Question: In a single sentence, describe what this figure presents.
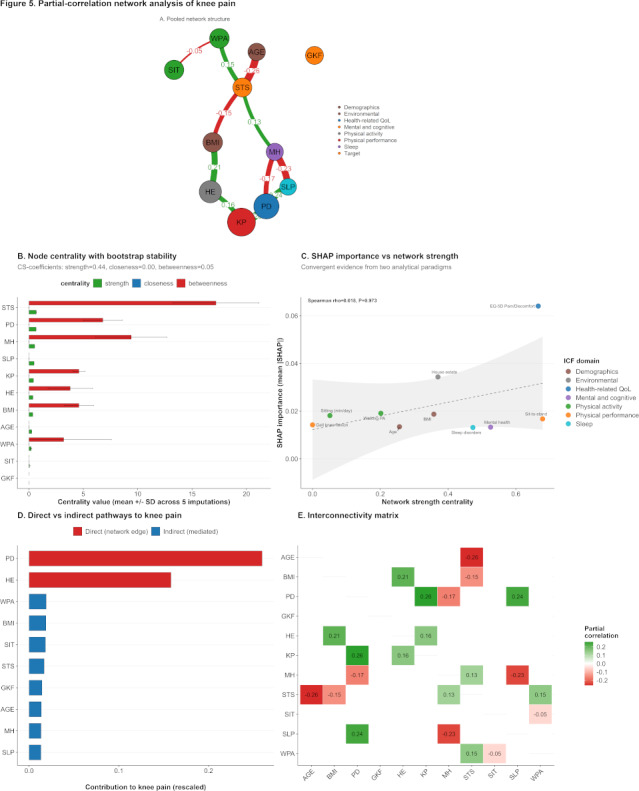
Answer: Partial-correlation network, centrality, paradigm concordance, and pathway decomposition. (A) Pooled network structure, (B) node centrality with bootstrap stability, (C) linkage between SHAP importance and network strength centrality, (D) direct versus indirect pathways to knee pain, and (E) interconnectivity matrix. CS: correlation-stability; EBICglasso: graphical LASSO with extended Bayesian information criterion regularization; GKF: gait knee flexion; HE: house estate; ICF : International Classification of Functioning, Disability and Health ; KP: knee pain; LASSO: Least Absolute Shrinkage and Selection Operator; MH: mental health; ML: machine learning; PD: EQ-5D-5L Pain/Discomfort dimension; SHAP: SHapley Additive exPlanations; SIT: sitting timea; SLP: sleep disorders; STS: sit-to-stand; WPA: walking physical activity; QoL: quality of life.